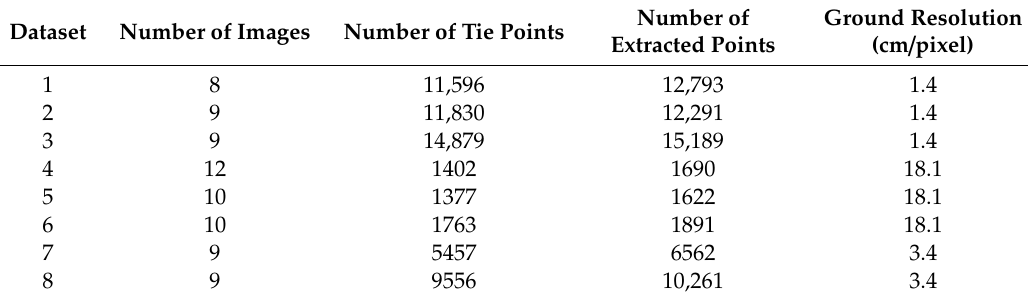
Table 3. Results of Photoscan (high